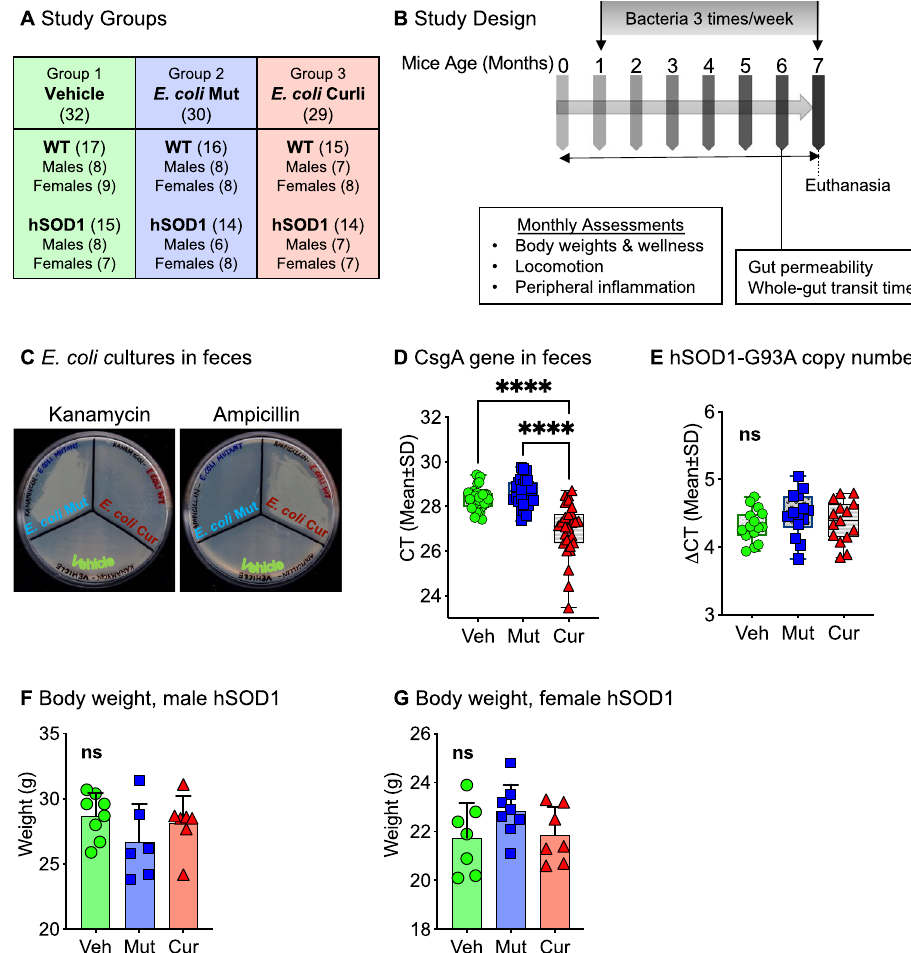
Figure 1. Study design. ( A ) There were a total of 91 animals in 3 main experimental groups—Group 1: Vehicle (applesauce only), Group 2: E. coli mutant in applesauce (lacking CsgA gene), Group 3: E. coli curli in applesauce (CsgA/curli producing). ( B ) Mice were assessed at baseline (3 weeks of age) and monthly for several functional measures as indicated. Feeding of bacteria or vehicle was started at 1 month of age, three times/week, for 6 months. ( C ) Confirmation of feeding—bacteria from fecal pellets were cultured in kanamycin and ampicillin agar plates, demonstrating resistance of E. coli -mutant to kanamycin and E. coli -curli to ampicillin antibiotics, respectively. ( D ) Confirmation of feeding—presence of CsgA gene were evaluated in DNA isolated from feces. qPCR was run from equal starting amount of DNA from all 3 feeding groups, which detected overexpression of CsgA in the curli-fed group, as well as endogenous expression in the vehicle and mutant groups ( E ) Copy numbers of hSOD1-G93A transgene in mice in all 3 feeding groups were not significantly different ( F and G ) There were no significant differences in body weights of mice at 7 months of age between bacterial fed groups. ns = not significant, **** p < 0.001, one-way ANOVA, n = 6–8 per